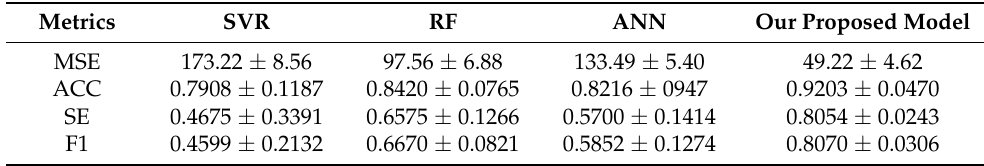
Table 3. The regression and classification results (mean ± STD) of our proposed model and three conventional models in cross-subject